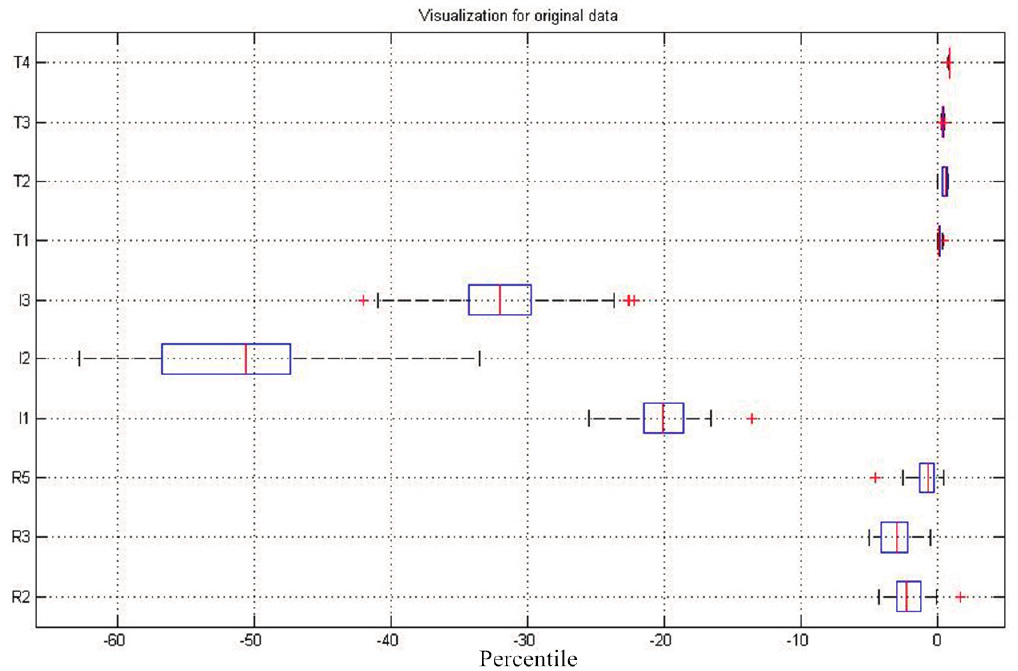
Figure 16. Calibration process of the range estimation